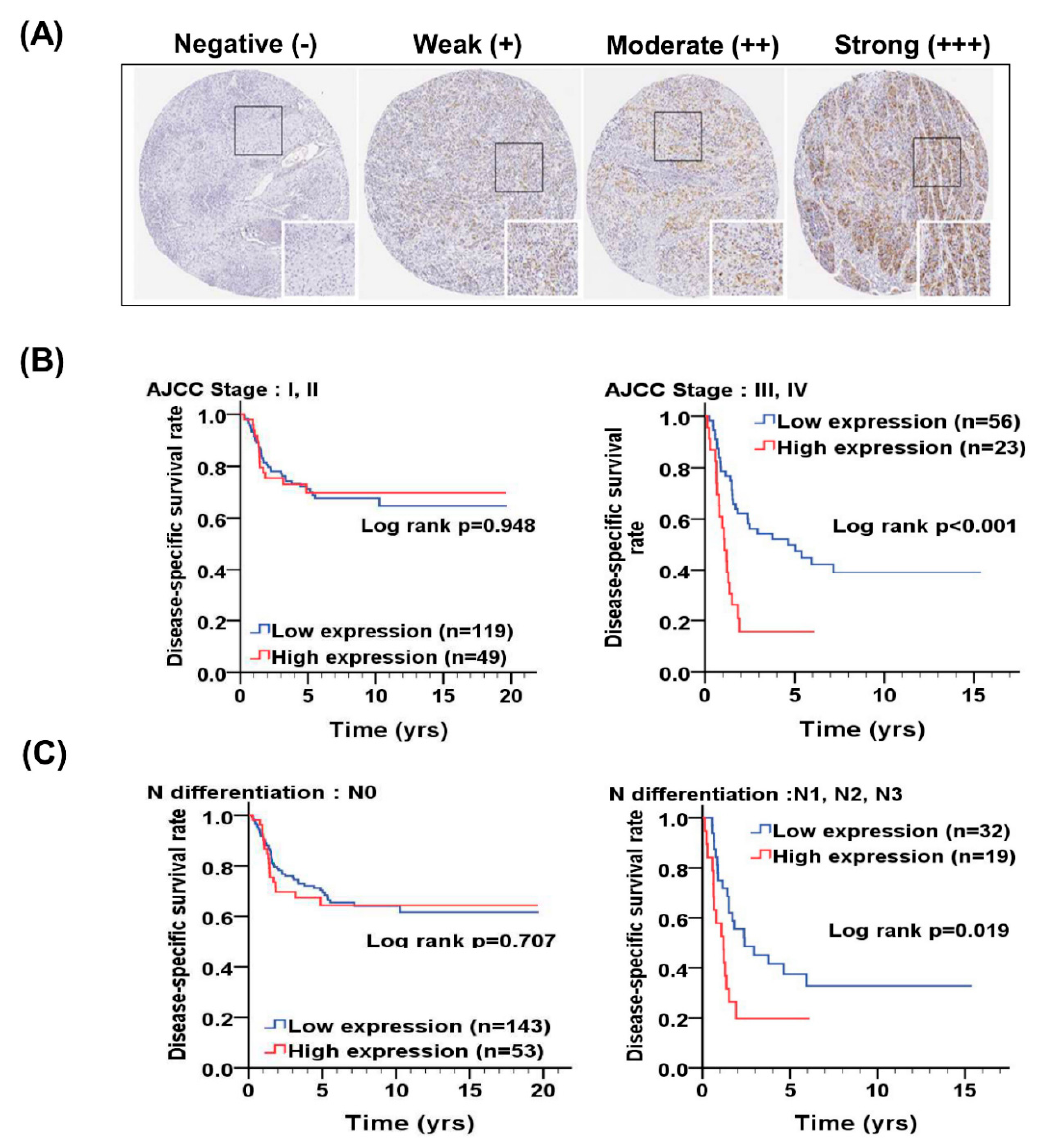
Figure 1. Representative immunohistochemical staining of UBE2C in tumor tissues and compared DSS of OSCC patients according to expression level of UBE2C. ( A ) The expression level of UBE2C was determined using a numerical scale (no signal ( − ), weak ( + ), moderate ( ++ ) or strong ( +++ ) staining) for scoring intensity. ( B ) The comparison of DSS in OSCC patients with early pathological stage (I + II) and advanced pathological stage (III + IV) according to expression level of UBE2C. ( C ) The comparison of DSS in OSCC patients without lymph node metastasis (N0) and with lymph node metastasis (N1, N2, N3) according to expression level of UBE2C.